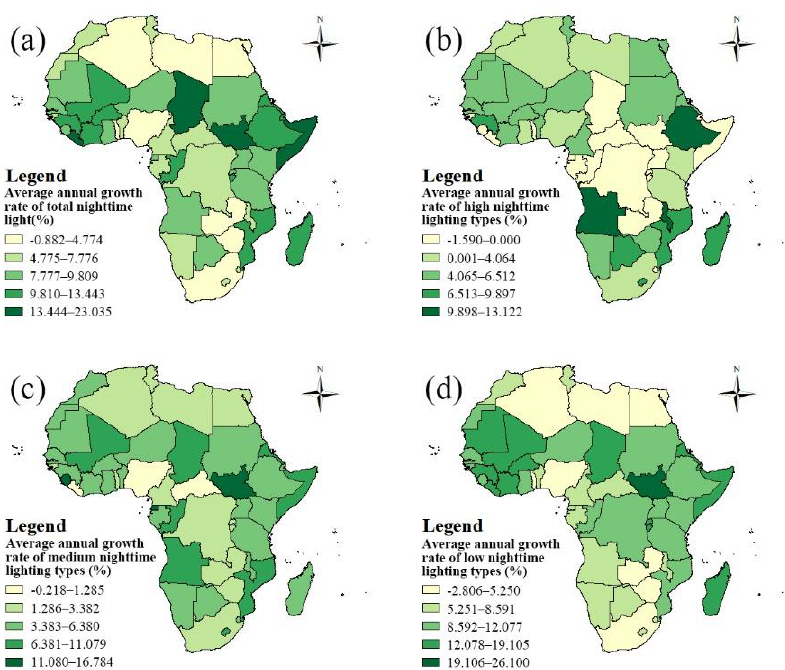
Figure 8. Average annual growth rate of: ( a ) total nighttime light; ( b ) high nighttime lighting types; ( c ) medium nighttime lighting types; ( d ) low nighttime lighting types.